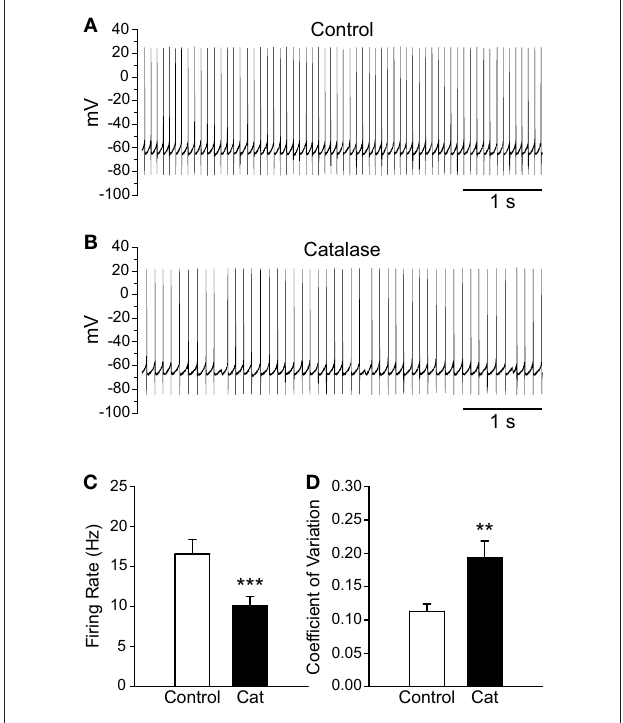
O levels increases SNr GABAergic FiGuRe 4 | Depletion of endogenous H 2 2 rate of SNr GABAergic neurons and decreases the regularity of their spontaneous activity. (A) Spontaneous activity of a SNr GABAergic neuron O with MCS under control conditions and (B) after depletion of endogenous H 2 2 catalase (500 U/mL). (C) Catalase (Cat) caused a decrease in the spontaneous firing rate of SNr GABAergic neurons. (D) In addition, spontaneous activity O . (*** p < 0.001). became more irregular in catalase, reflected in an increase in the coefficient of 2 2 variation. (** p < 0.01; *** p